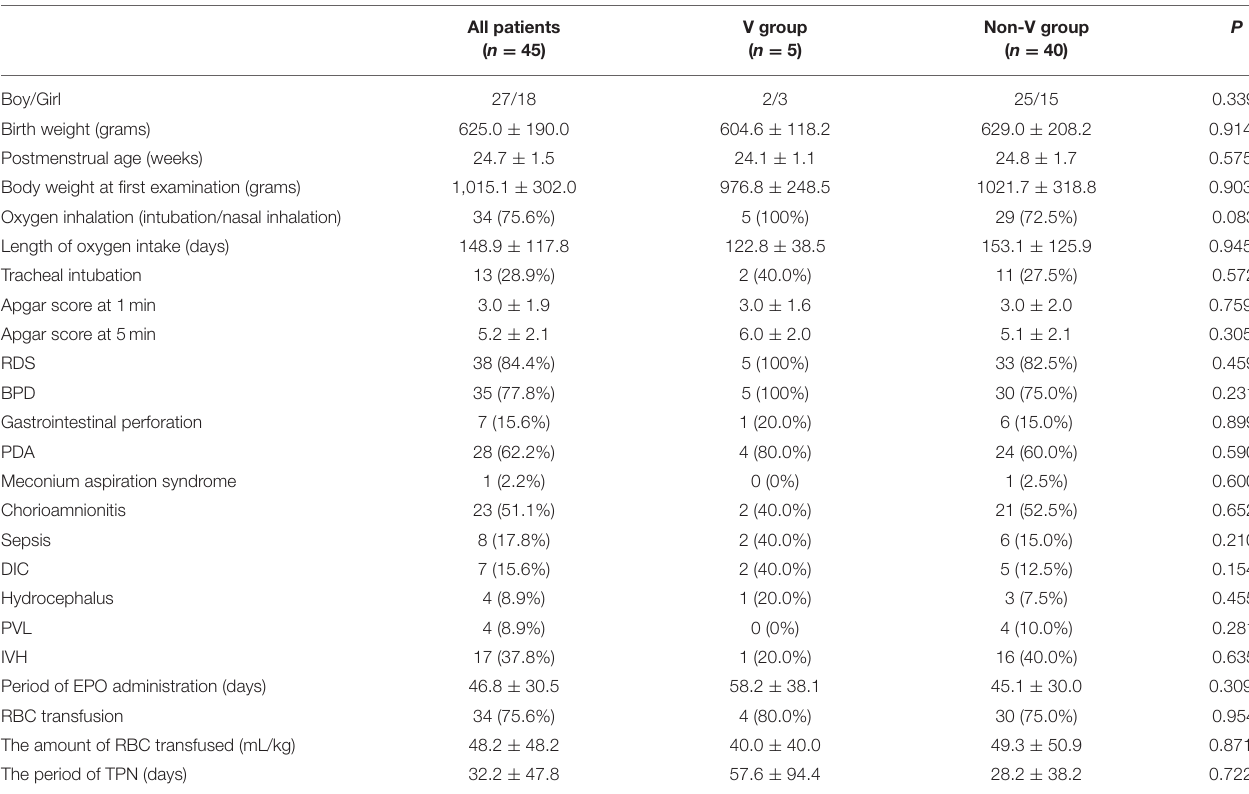
TABLE 1 | Demographic characteristics of the study groups.